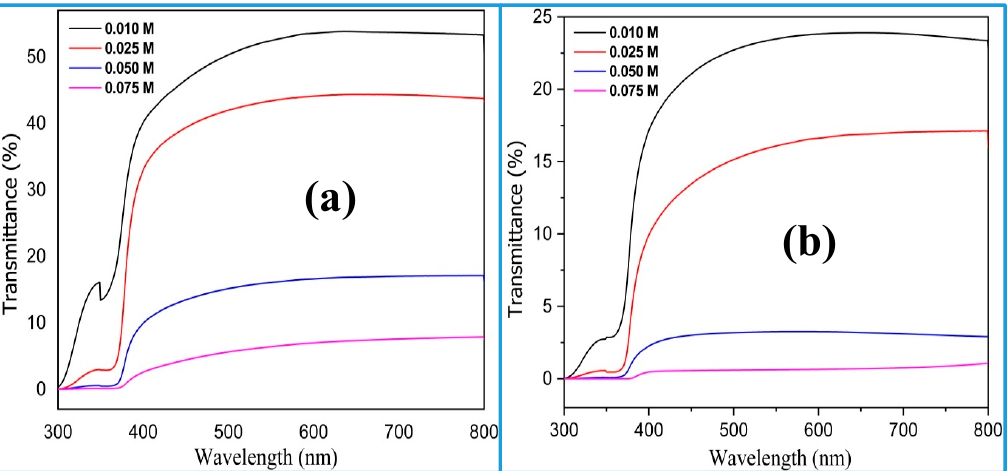
Figure 11. Optical transmittance spectrum of ZnO nanorods synthesized at different precursor concentration in the ( a ) absence and ( b ) presence of air bubbles.